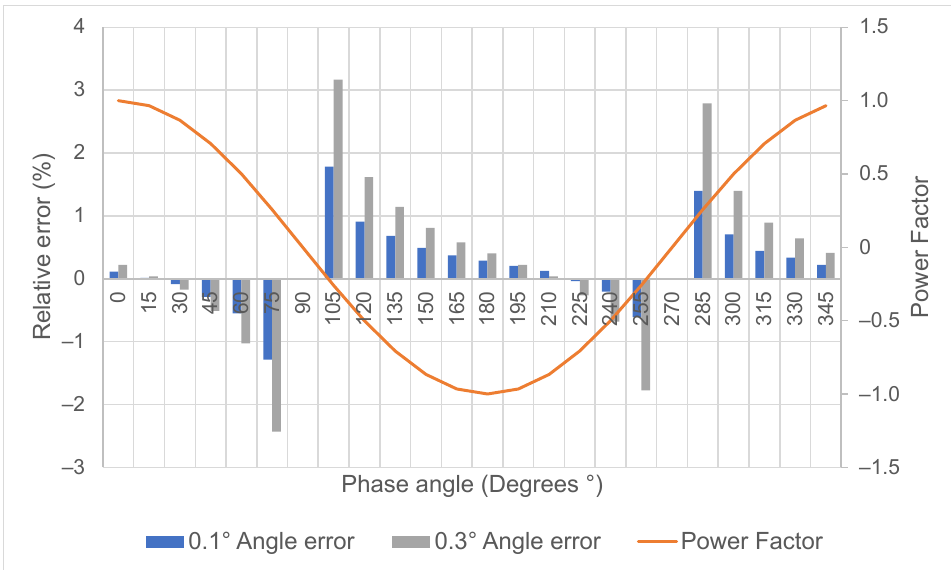
Figure 9. Total active power relative error versus phase shift.